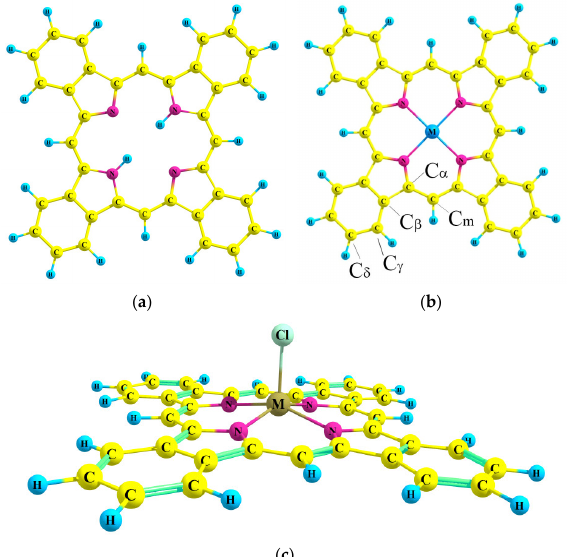
Figure 1. Molecular models of metal-free tetrabenzoporphyrin ( a ), its complexes MTBP with Zn, Cd ( b ), MClTBP with Al, Ga, In ( c ). The degree of the doming distortion for MClTBP can be described by the dihedral angle α between planes of opposite pyrrole rings. Its values were 176°, 176° and 172° for AlClTBP , GaClTBP and InClTBP , respectively. The main geometric parameters are listed in Table 1. Table 1. Molecular parameters 1 of H 2 -tetrabenzoporphyrin and its metal complexes optimized at PBE0/def2-TZVP level. H 2 TBP